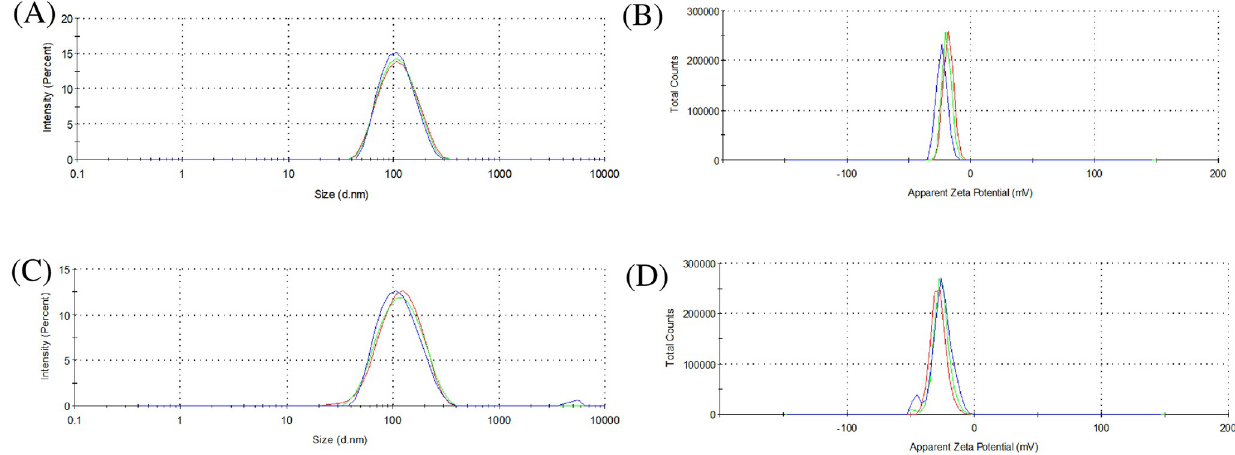
Fig 3. Size distribution by intensity and zeta potential distribution of nano-emulsion containing essential oil of A . triplinervis morphotype A (A and B) and morphotype B (C and D). The X axis has the particle diameter (nm) and the Y axis has the peak intensity (%).